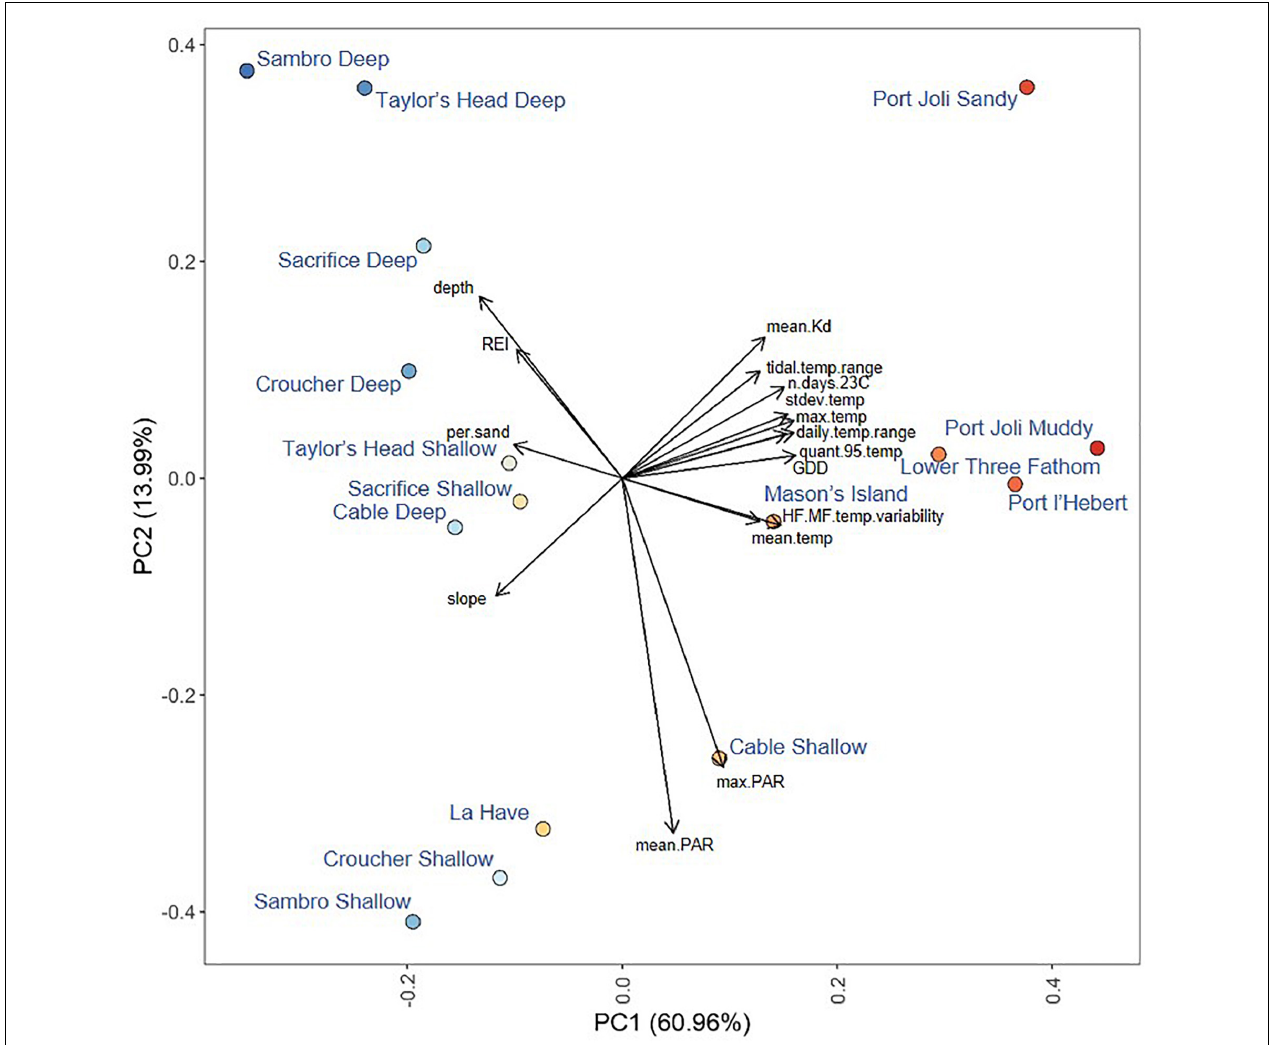
FIGURE 2 | Principal components analysis of environmental metrics measured at each site with currents excluded. Points are colored from red to blue according to their position along the first principal component. Loadings of environmental variables are shown by end points of the black arrows Variable abbreviations are defined in Table 1